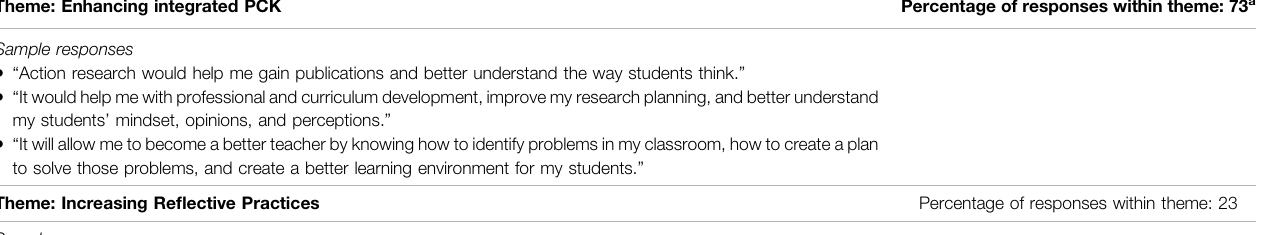
TABLE 6 | Emergent themes from participants ’ responses to the question: “ What long-lasting effects, if any, do you believe conducting an action research project would have on your professional career? ” Theme: Enhancing integrated PCK Percentage of responses within theme: 73